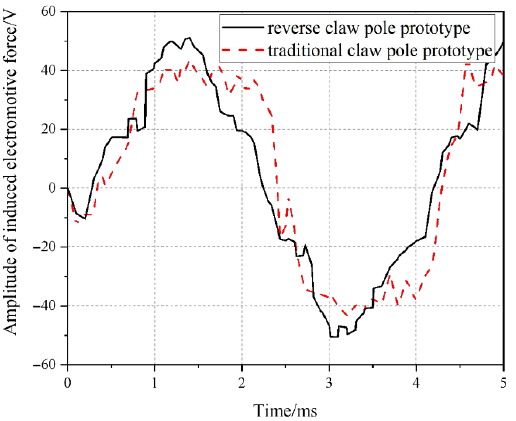
Figure 18. Curve change diagram of induced electromotive force under 50 Ω load.